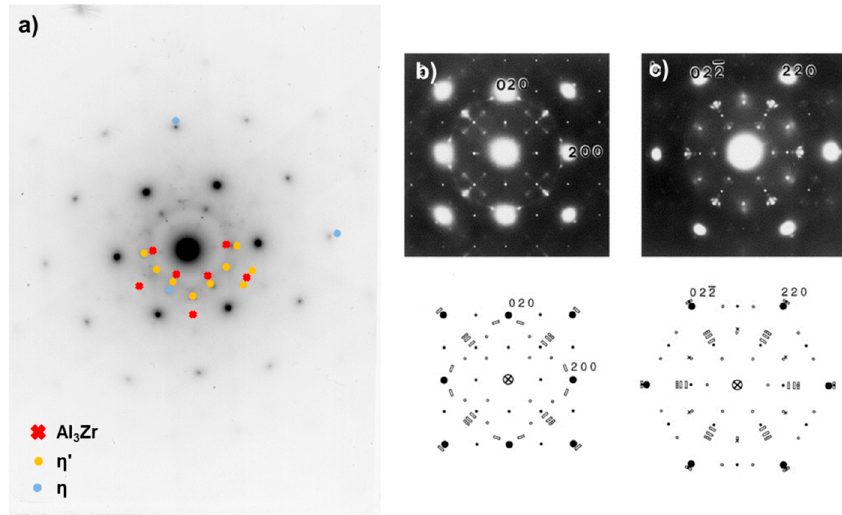
Figure 5. Diffraction analysis (selected area diffraction pattern) of the particles in sample IQ200 T6 and a comparison with literature data ([111] Al projection). The results ( a ) and schematic representation from literature [24]: small open circles- η ’, crosses–GP(II), rectangles–several orientation variants of η -MgZn 2 ( b , c ).